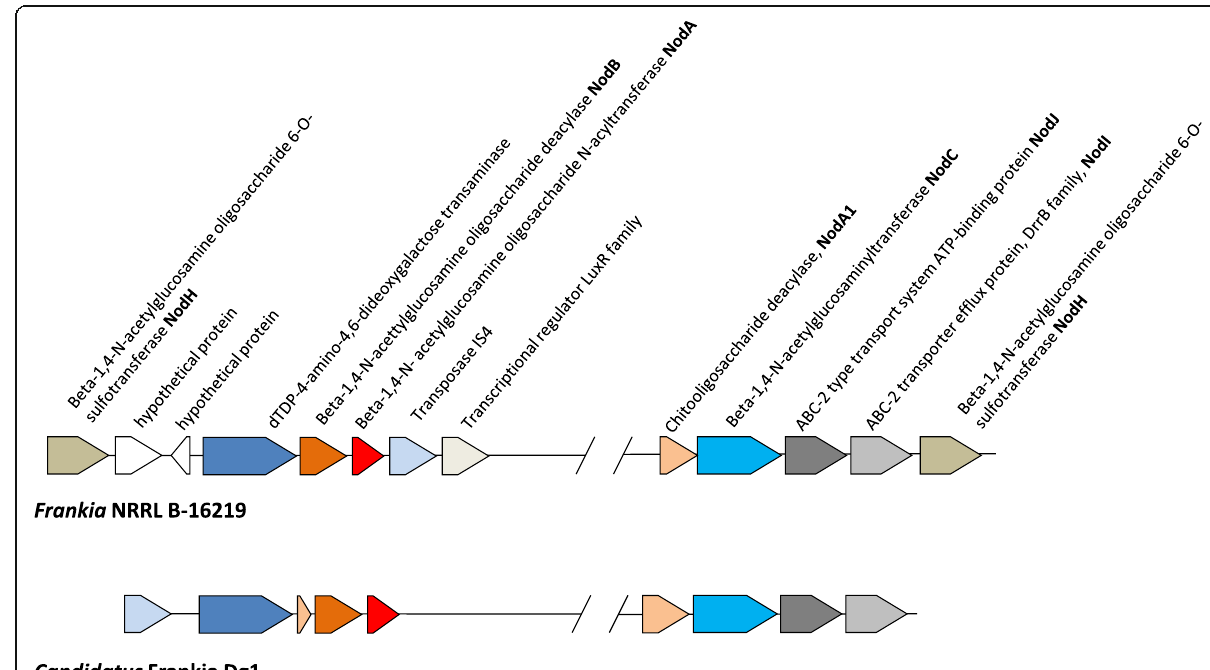
Fig. 3 Organization of nod genes in Frankia NRRL B-16219 and Candidatus Frankia datiscae Dg1 genomes. Sizes, localization and orientation of the genes are displayed proportionally. These genes are not detectable in any other Frankia genome except Candidatus Frankia